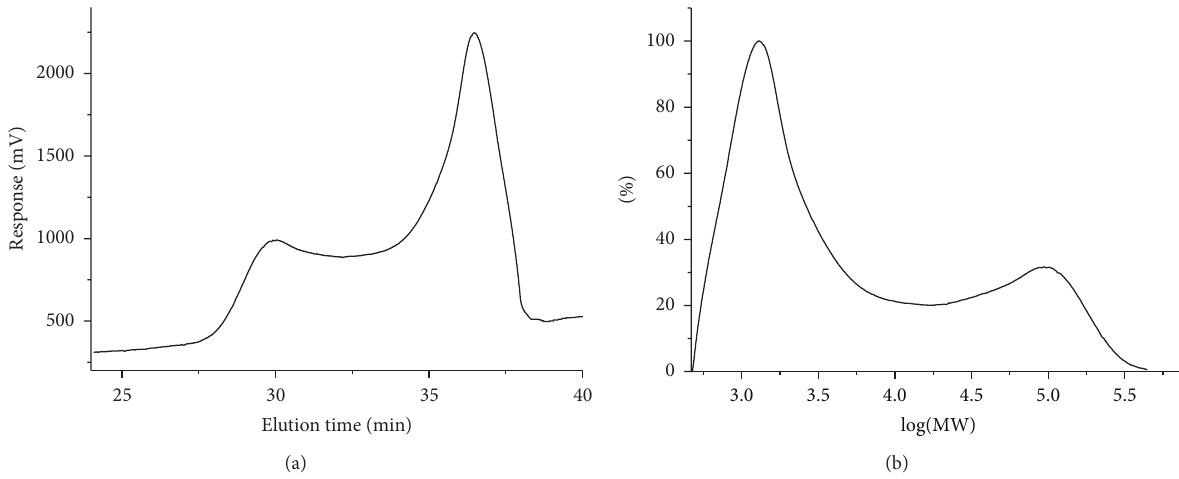
Figure 7: GPC elution (a) and MWD (b) curves for sample number 17 ( [𝜂] = 1.02 dL/g, see Table